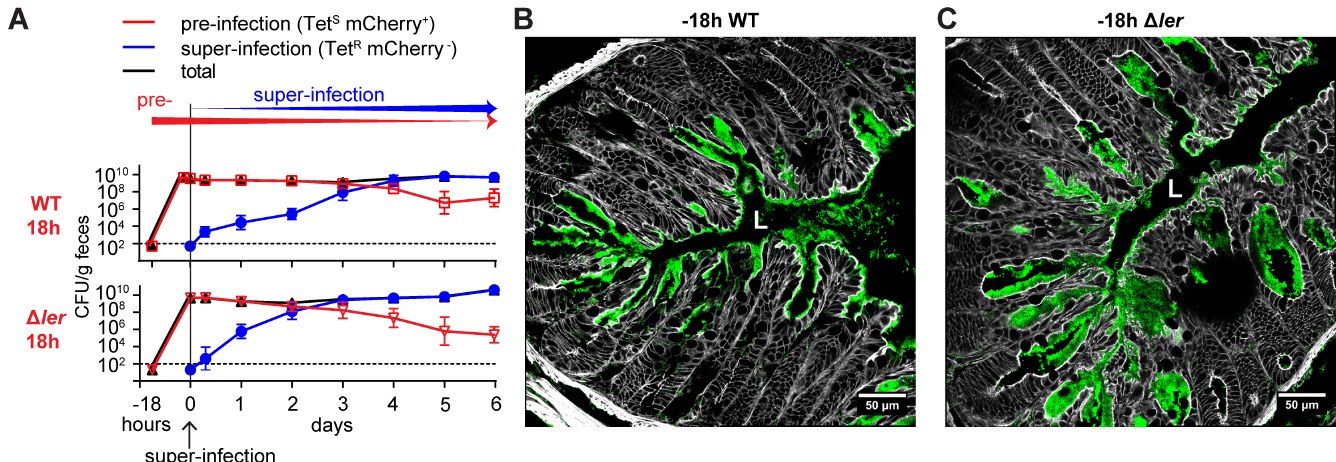
Fig 6. Ongoing A/E lesion induction in mice deficient for innate signaling through MyD88 and Trif. ( A ) Coloniccolonization dynamicsin MyD88 -/- Trif lps/lps germ-free mice consecutively infected, first with mCherry + Kan R Tet S C . rodentium wild type (WT) or an isogenic Δ ler mutant (10 10 CFU, red squaresand triangles), and 18 hours later superinfected with mCherry - Kan S Tet R C . rodentium wild type (10 4 CFU, blue circles). Total C . rodentium counts are depictedas black symbols. Connectinglines connect means; error bars indicatestandard deviation; horizontaldotted lines indicate detection limit. ( B and C ) Representative fluorescent microscopyimages of distal colon of MyD88 -/- Trif lps/lps mice shown in panel A pre-infected with wild type (B) and Δ ler (C) C . rodentium ,respectively.Grey, F-actin/phalloidin;green, anti- Citrobacter O-antigenantibody(pre-infection strain and superinfecting strain); red, mCherry-expressing C . rodentium (pre-infection strain only; none detectable). Scale bars: 50 μ